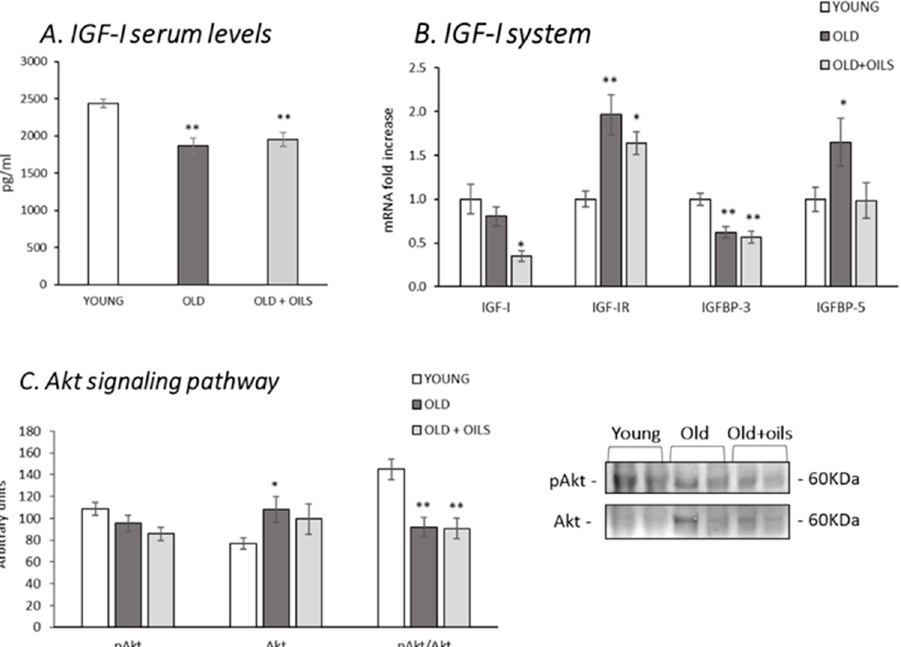
Figure 3. Oil mixture treatment did not prevent the age-induced decrease of IGF-I serum levels and the muscle Akt signaling pathway, although it did prevent increased expression of muscle IGFBP-5. Figures show ( A ) insulin-like growth factor (IGF-I) serum levels; ( B ) gastrocnemius IGF-I, IGF-I receptor (IGF-IR), IGF-I binding protein 3 (IGFBP-3), and 5 (IGFBP-5) mRNA levels; ( C ) gastrocnemius protein levels and ratio between phospho Akt (pAkt) and Akt of young rats ( n = 11), old rats ( n = 8) and old rats treated for 21 days with the oil mixture (OLD + OILS, n = 5). Values are represented as mean ± standard error of the mean (SEM). Statistics: ** p < 0.01 and * p < 0.05 vs. Young, by least-significant difference post hoc analysis after significant one-way analysis of variance (ANOVA).